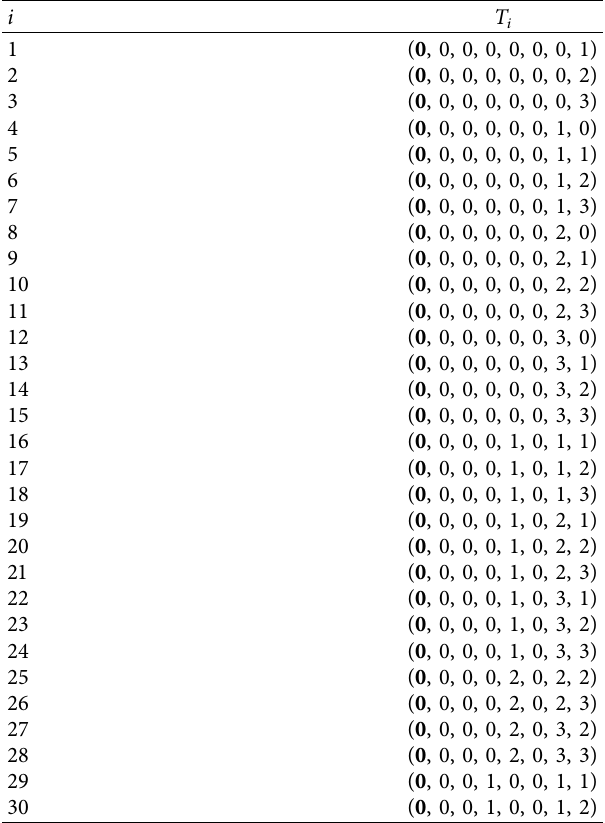
Table 14: First 30 1-Lag temporal vectors generated from T � (0, 2, 2, 2, 2, 1, 3,